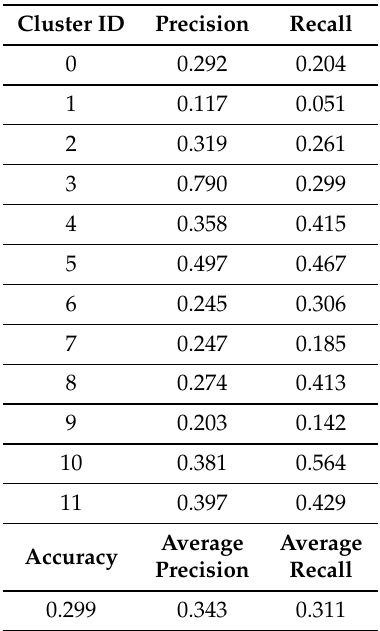
Table 6. Metrics with only geometric